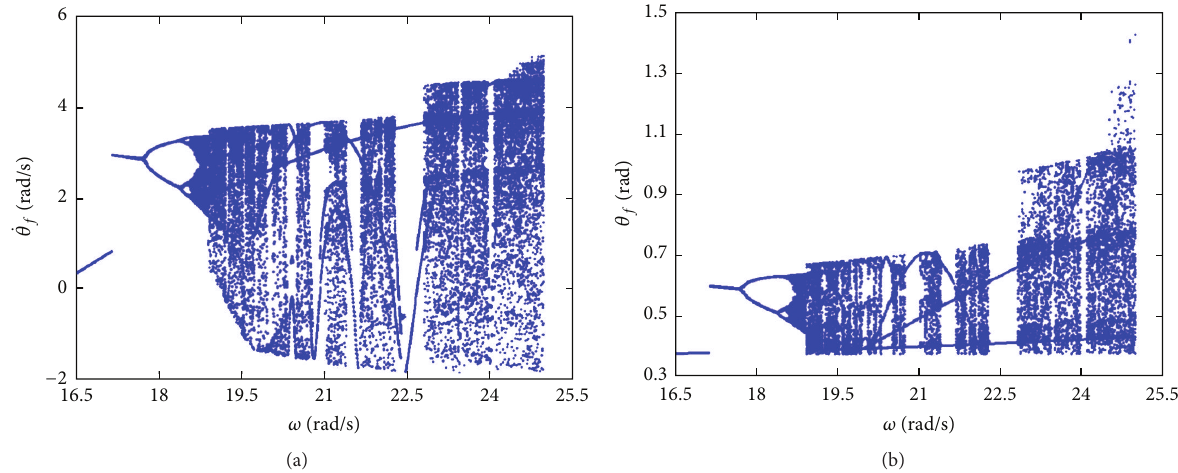
Figure 3: Bifurcation diagram with the change of cam speed: (a) angular velocity and (b) angular displacement.